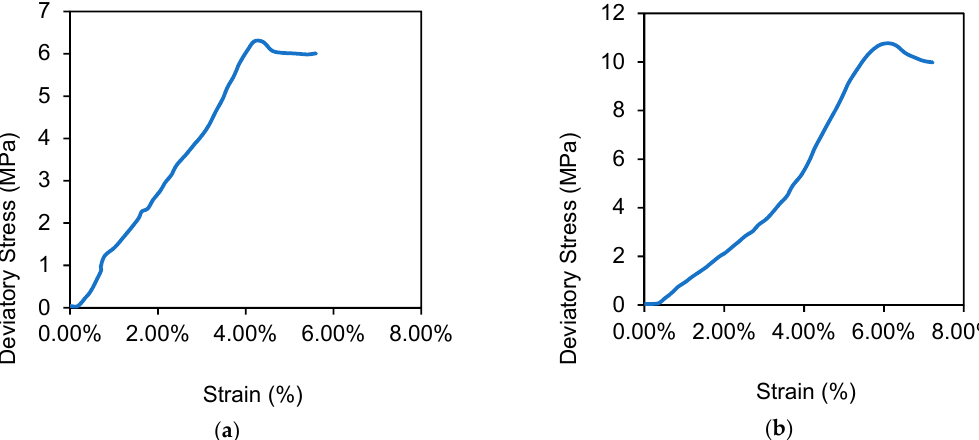
Figure 6. Stress – strain curve of 3D printed rock ( a ) cylindrical sample 1 and ( b ) cylindrical sample 2 made of gypsum-powder.